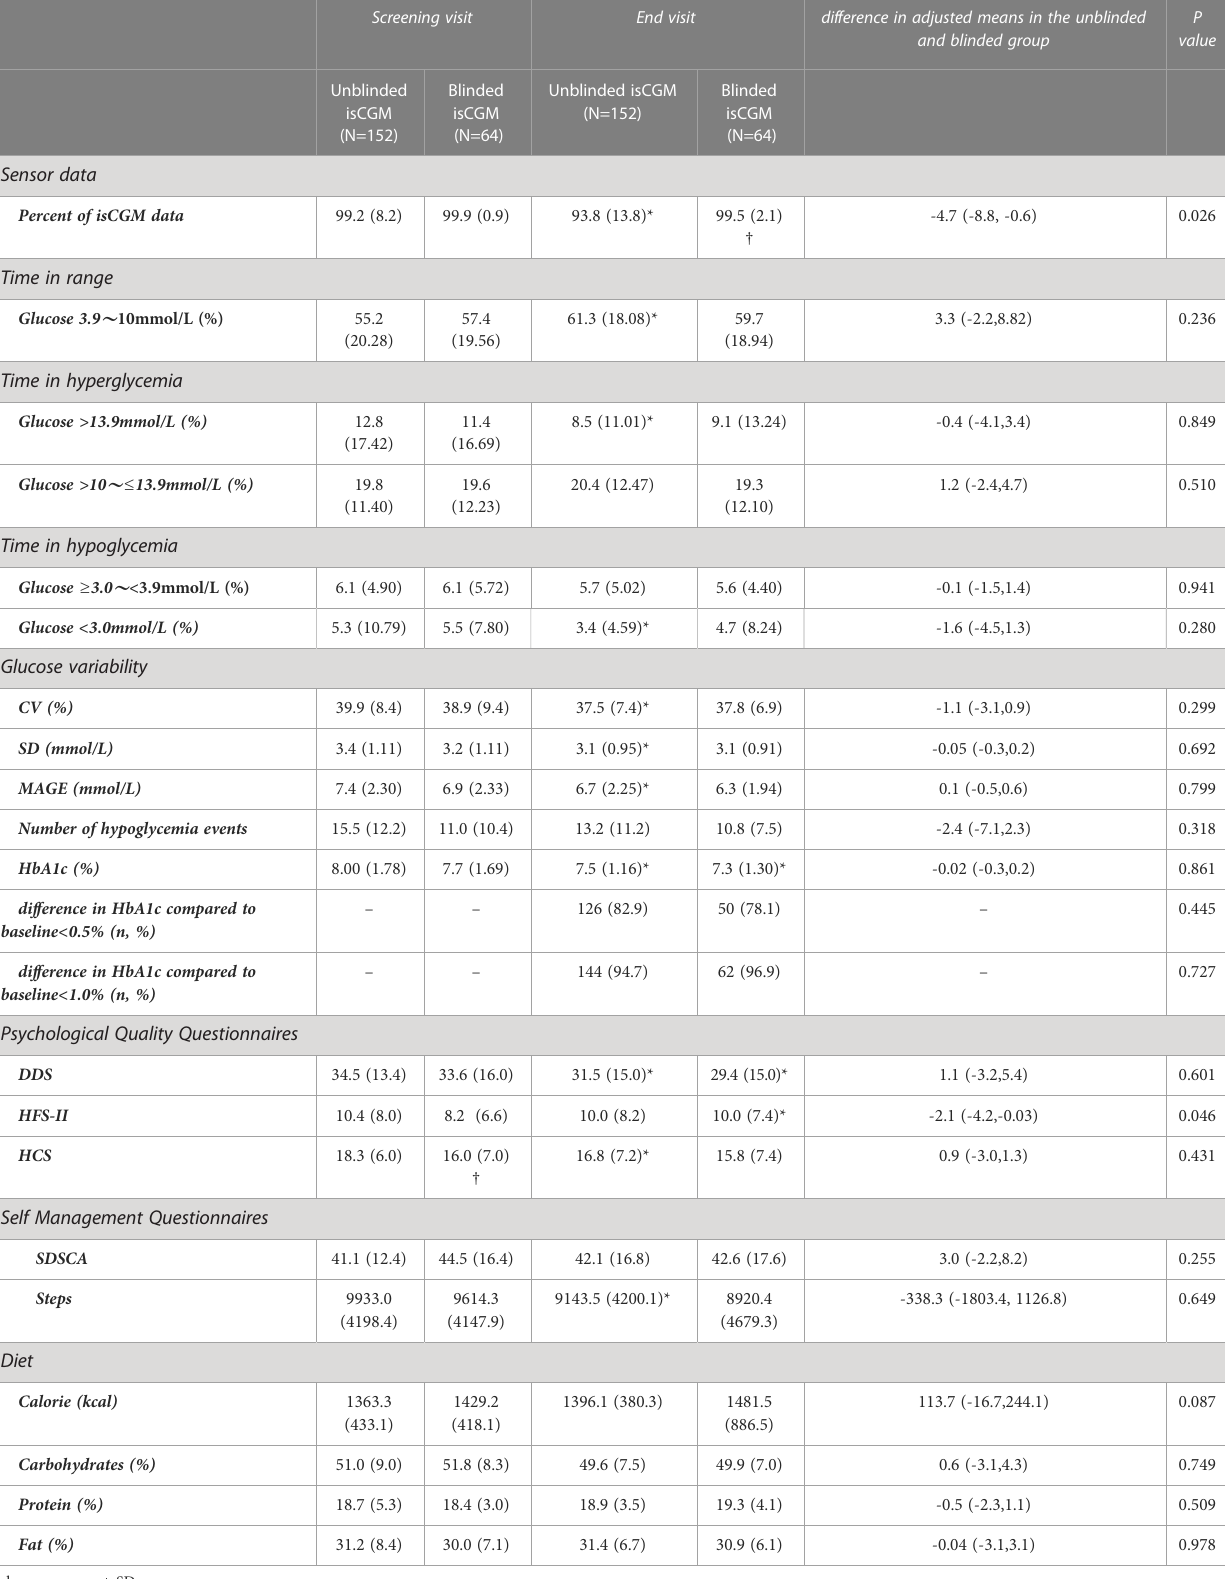
TABLE 2 Glycaemic and glucose variability outcomes in a study of the ef fi cacy of unblinded and blinded intermittently fl ash continuous glucose monitoring on glycemic control in adults with type 1 diabetes. Screening visit End visit difference in adjusted means in the unblinded P and blinded group value Blinded